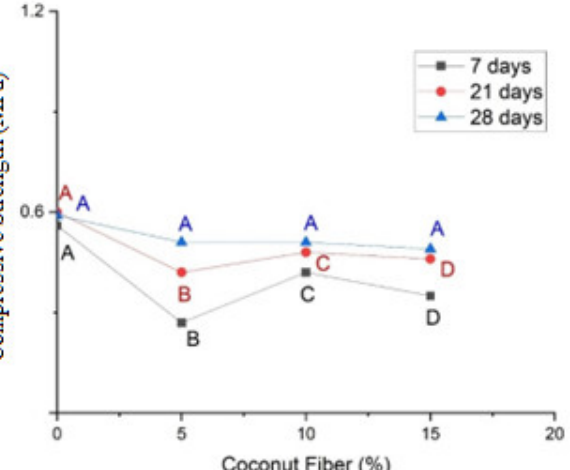
Figure 8. Mechanical compressive strength (MPa). Different letters on the line mean that there was a statistically significant difference.